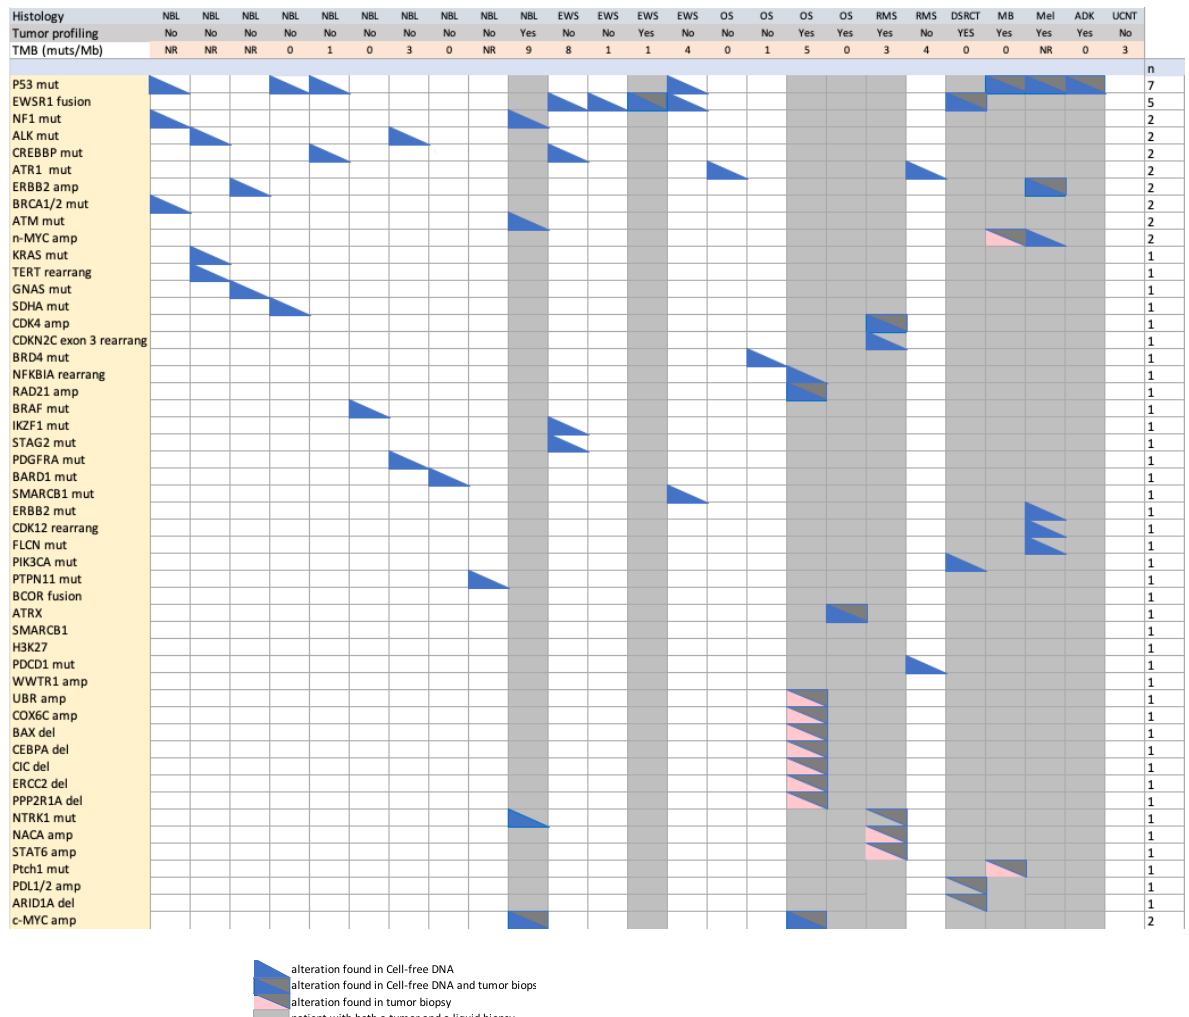
Figure 2. Oncoplot of molecular alteration and TMN found in liquid biopsies and tumor biopsies. Abbreviations used: TMB, tumor mutational burden; amp, amplification; rearrang, rearrangement; NR, not reported in LB results. NBL: neuroblastoma; EWS: Ewing sarcoma, OS: osteosarcoma; RMS: rhabdomyosarcoma; MB: medulloblastoma; DSCRT: desmoplastic small round cell tumor; Mel: melanoma; ADK: adenocarcinoma; UCNT: undifferentiated carcinoma of the nasopharynx.